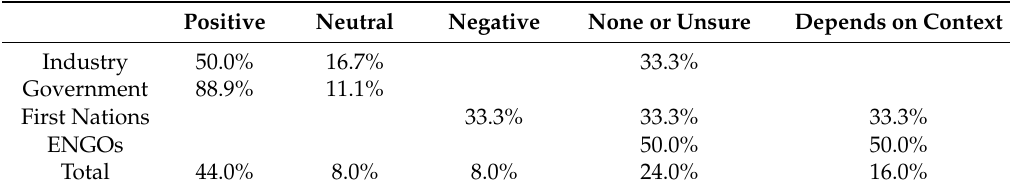
Table 3. Organization’s attitude (as reported by participant) regarding genomic tools in British Columbia (BC) forests, represented as a proportion of each group and as sample population